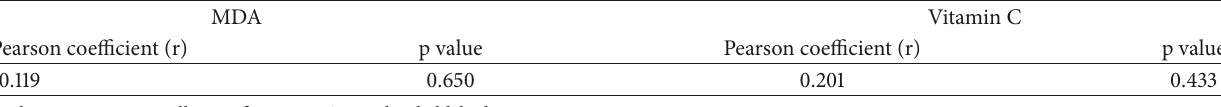
Table 3: Correlation analysis of MDA and vitamin C (ascorbic acid) against hemoglobin level among participants.